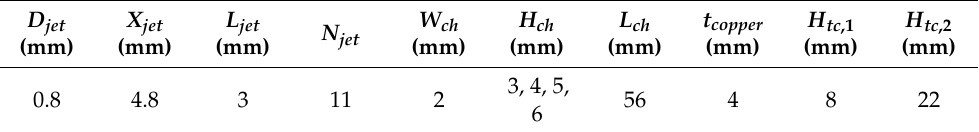
Table 1. Test section dimensions.